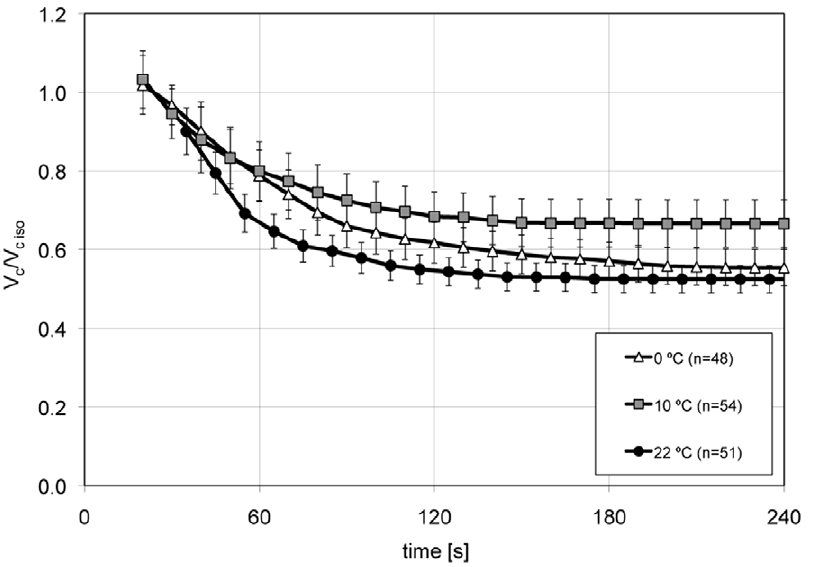
Figure 3. Normalized shrink curves of COS-7 cells in hypertonic (602 mOsm/kg) TBS. The cell volumes were normalized to the mean isotonic volume at each temperature; namely, 3324, 3920, and 3853 m m 3 . The data represent averages and S.E. values of 153 individually measured cells. Cells reached their equilibrium volume faster the higher the temperatures.